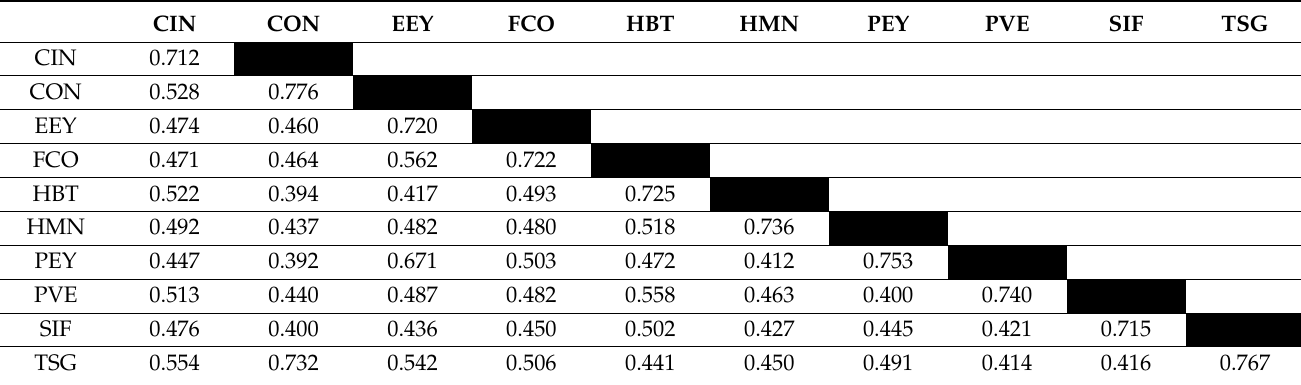
Table 3. Discriminant